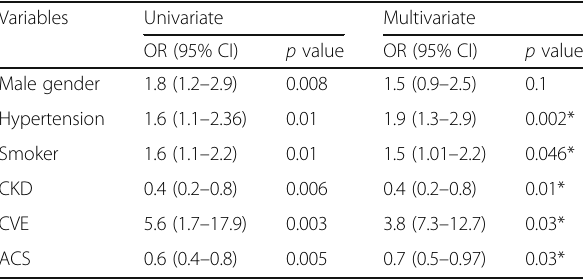
Table 2 Predictors of LEAD in patients with CAD Variables Univariate